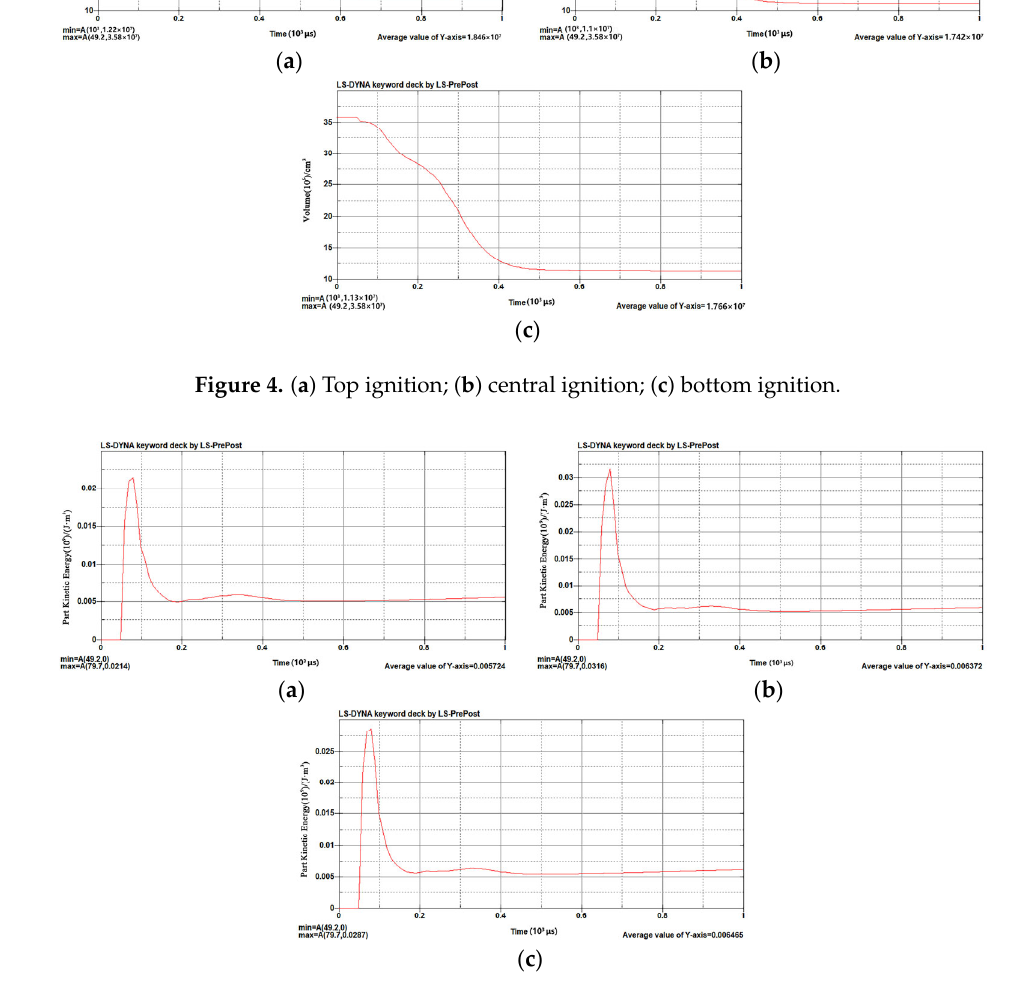
Table 5. Relationship between ignition position and ice blasting volume, final maximum pressure, and instantaneous kinetic